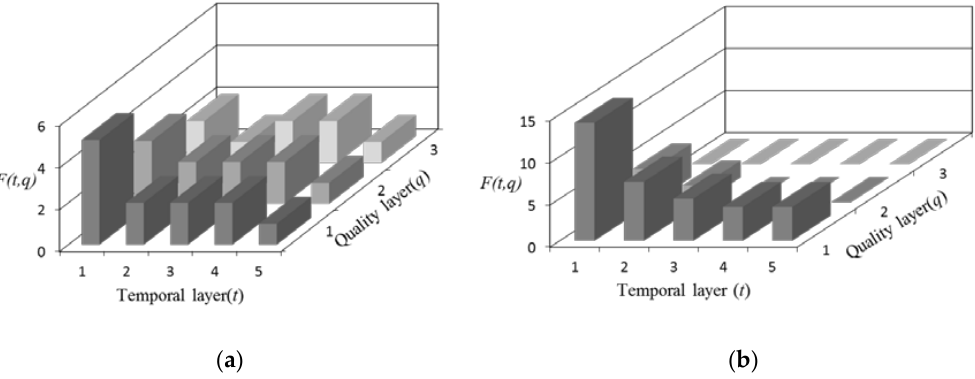
Figure 9. Distribution of F ( t , q ) for each temporal ( t ) and quality layer ( q ) for different packet loss rates in ‘Foreman’ test sequence ( a ) Pb = 5%; ( b ) Pb = 15%.